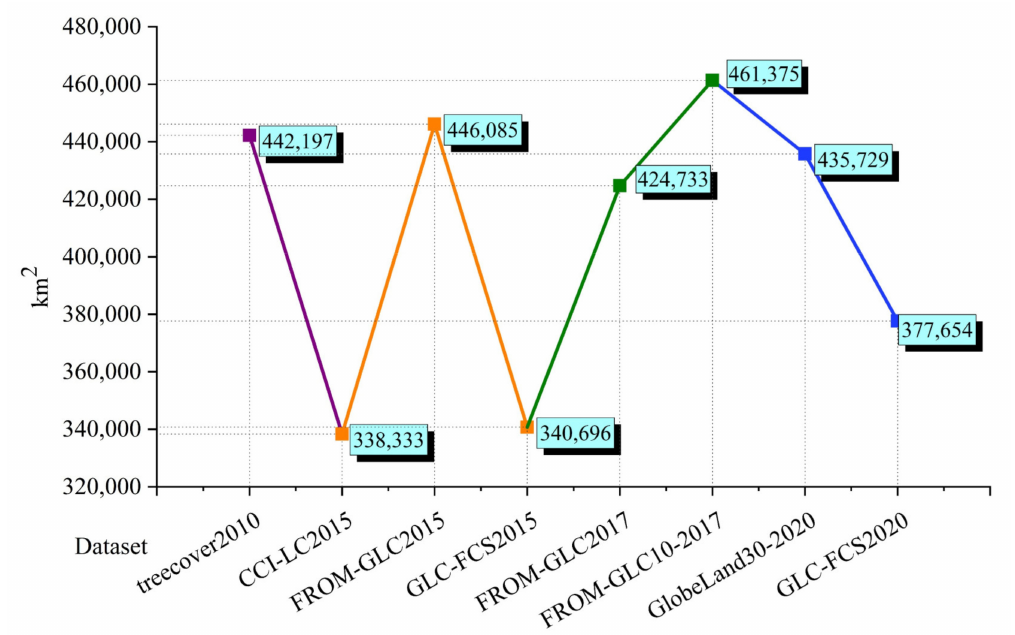
Figure 4. Eight global land cover datasets on forest area in Myanmar (Purple indicates the dataset of year 2010, Orange indicates the dataset of year 2015, Green indicates the dataset of year 2017, Blue indicates the dataset of year